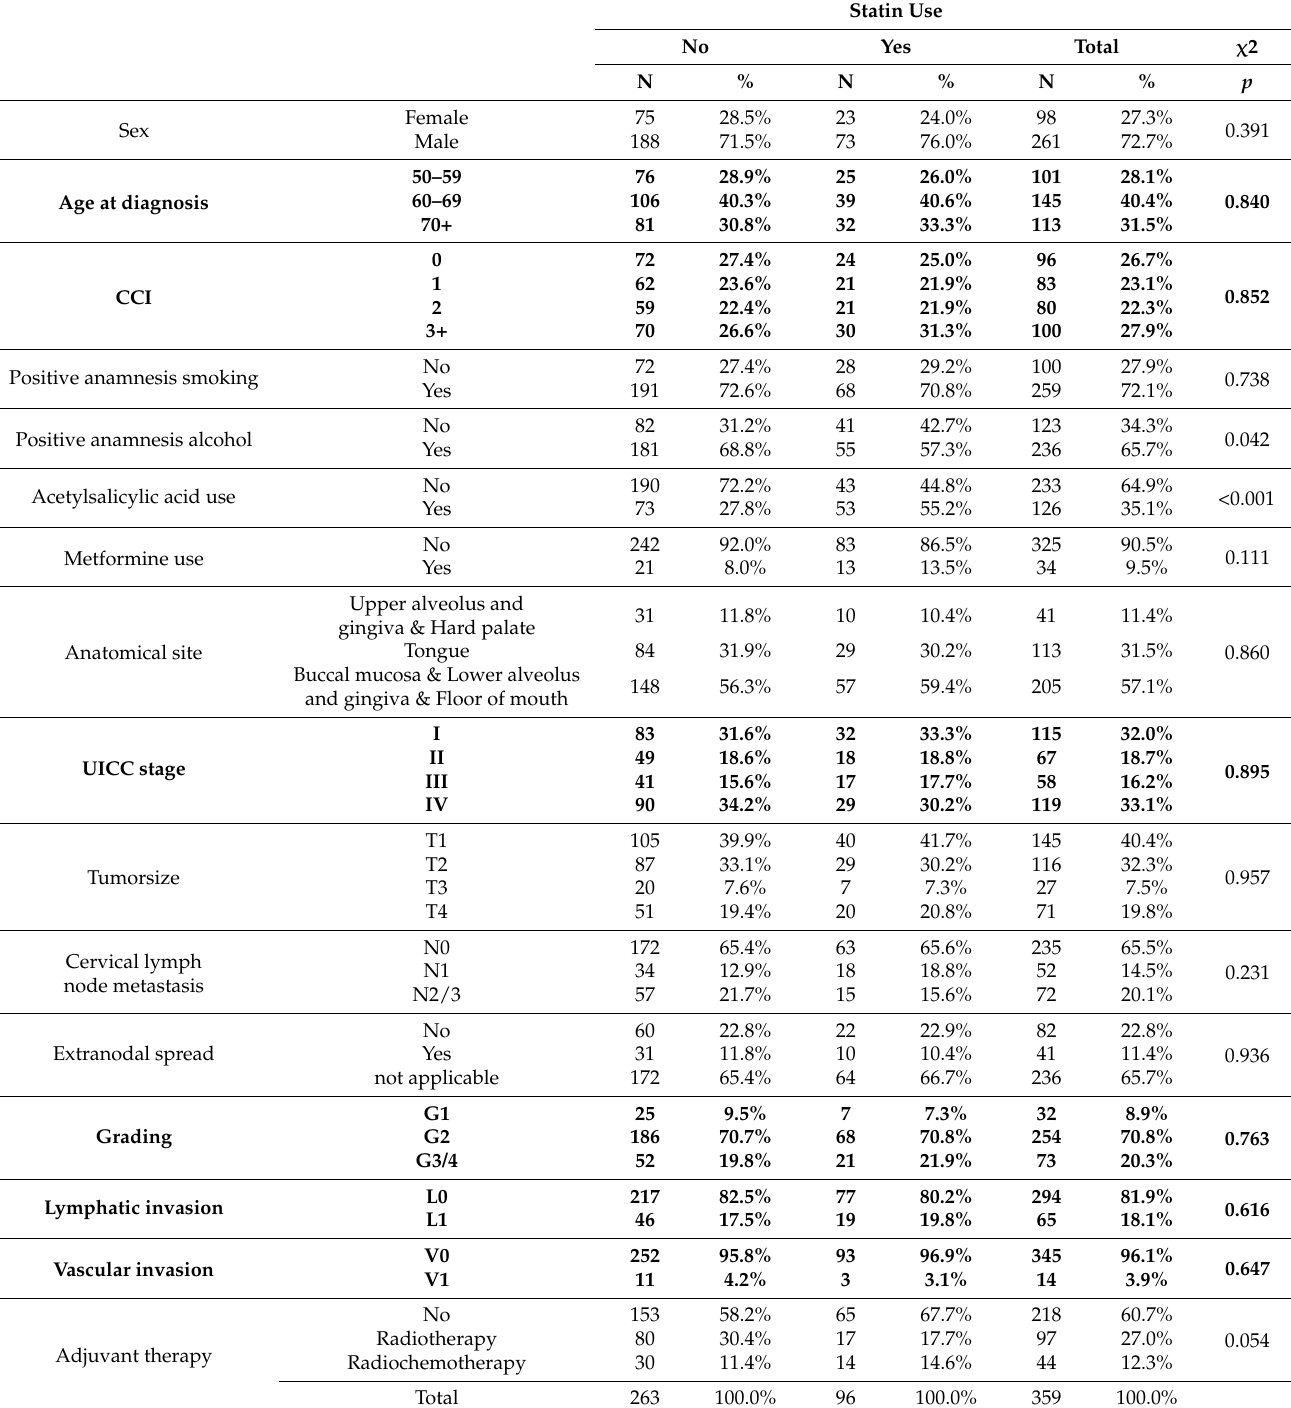
Table 1. Clinicopathological characteristics of OSCC patients according to statin use in the matched- pair cohort ( n = 359, matching variables are highlighted in bold). UICC 7th